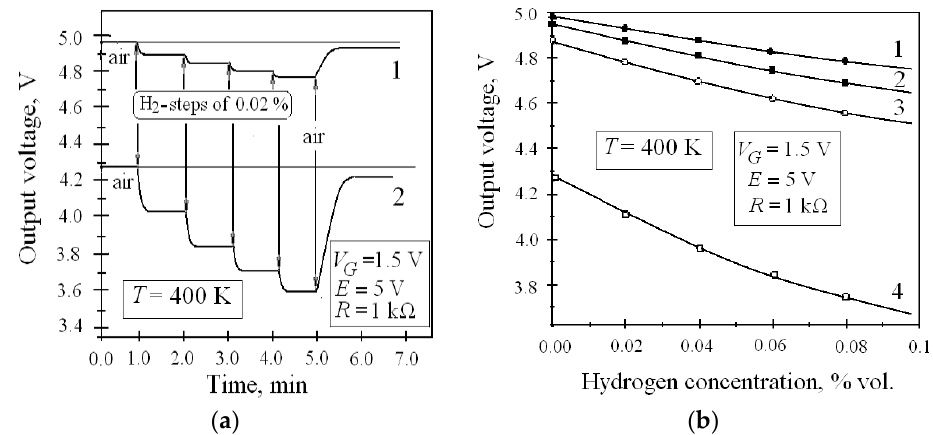
Figure 3. ( a ) The hydrogen responses before (1) and after (2) the irradiation by 850 Gy(Si) for circuit No. 1; ( b ) The output voltages V vs. C at doses D : 0(1); 100 Gy(Si) (2); 250 Gy(Si) (3); 850 Gy(Si) (4) for circuit No. 1.